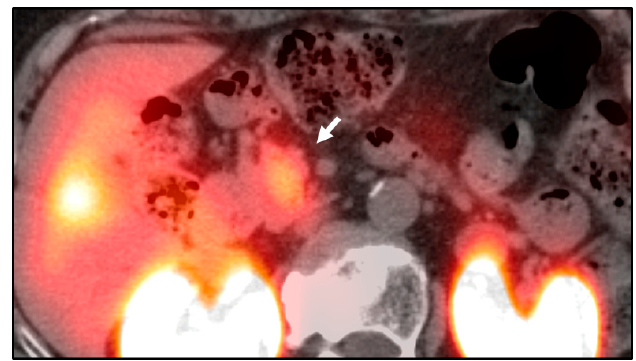
Figure 2. Occult insulinoma localized by 111 In-Octreotide. Axial SPECT/CT fusion demonstrates focal intense uptake within the uncinate process (arrow). A corresponding insulinoma was confirmed by biopsy. This insulinoma was occult on prior contrast enhanced magnetic resonance imaging (MRI).